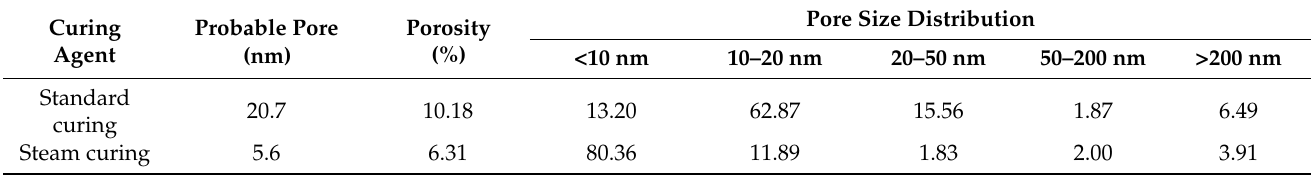
Table 7. The pore structure of S20F0G0* without defoamer under standard curing and steam